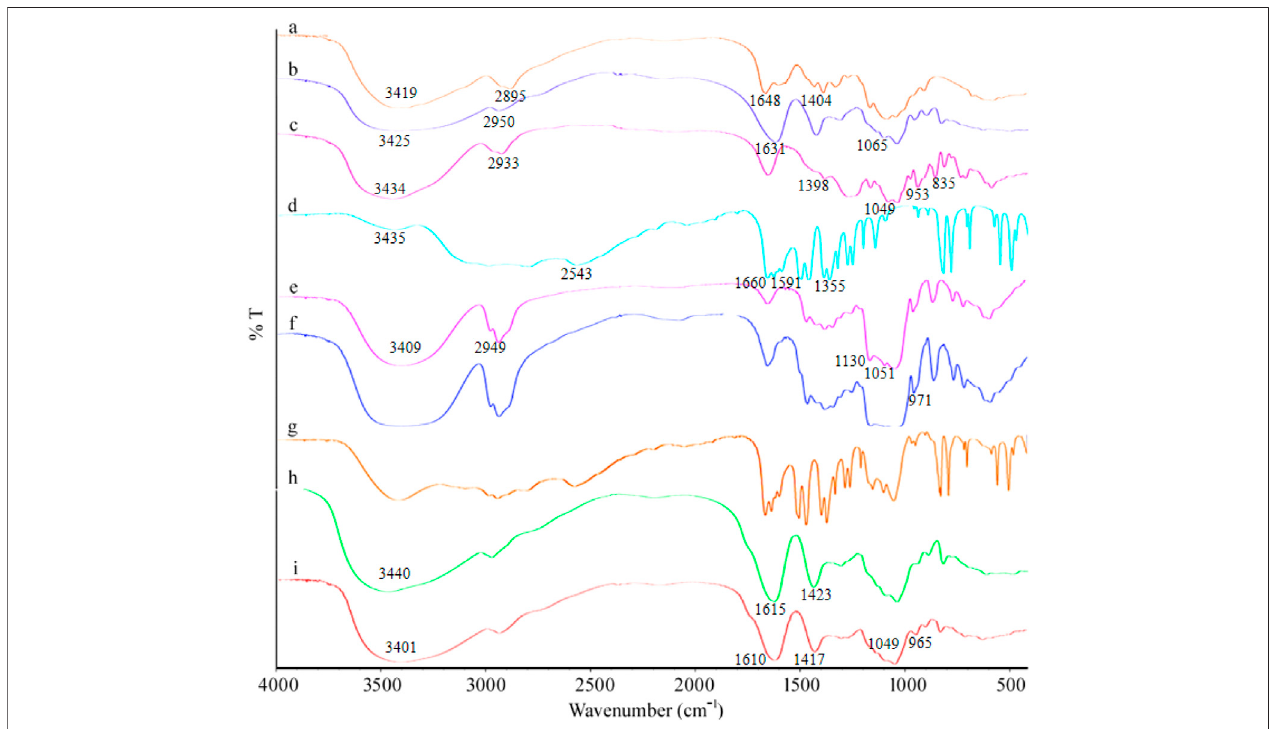
FIGURE 3 | FT-IR spectra. a, Alg; b, Cs; c, κ -Car; d, MSZ; e, HP- β -CD; f, inclusion complex of MSZ and HP- β -CD; g, physical mixture of MSZ and HP- β -CD; h, blank hydrogel; and i, drug loaded hydrogel.